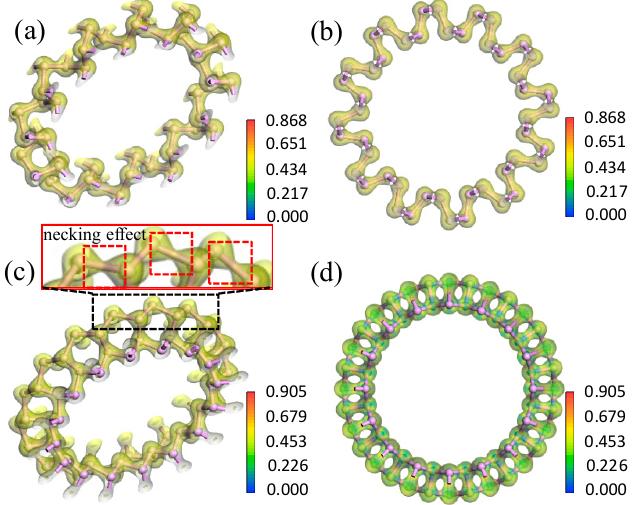
Figure 7. Electron density diagrams for ( a , b ) aPNT and ( c , d ) zPNT with a radius of 7.3 Å. ( a ) The rotated aPNT with electron density isosurface to show the weak difference in the electron distribution around the P atoms located at the inner and outer rings of Apnt; ( b ) The electron density profile vertical to the central axe of aPNT; ( c ) the rotated zPNT with electron density isosurface to show the necking effect shown around the P atoms located at the outer ring of zPNT and ( d ) the electron density profile vertical to central axe of zPNT.